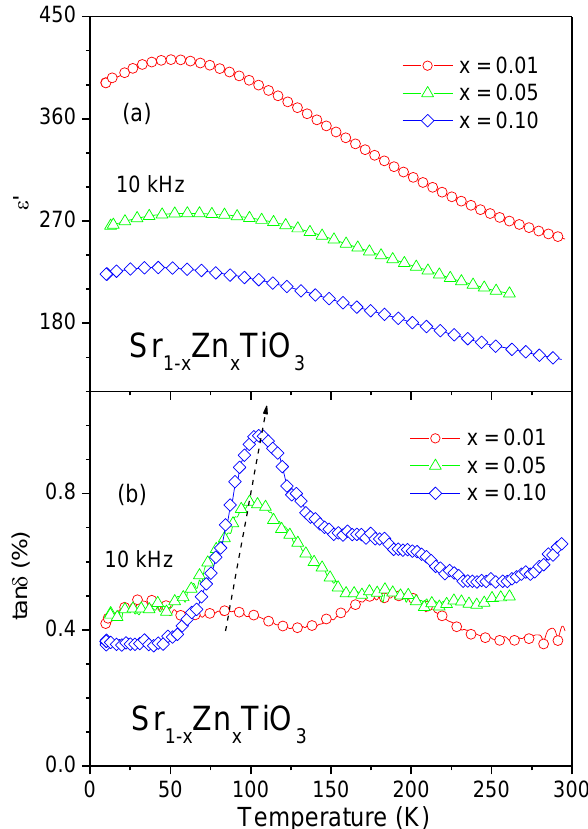
Figure 4. Temperature dependence of the real part of dielectric permittivity ε′ ( a ) and dissipation factor tan δ ( b ) for Sr 1-x Zn x TiO 3 thin films with x = 0.01, 0.05, and 0.10 at 10 kHz.